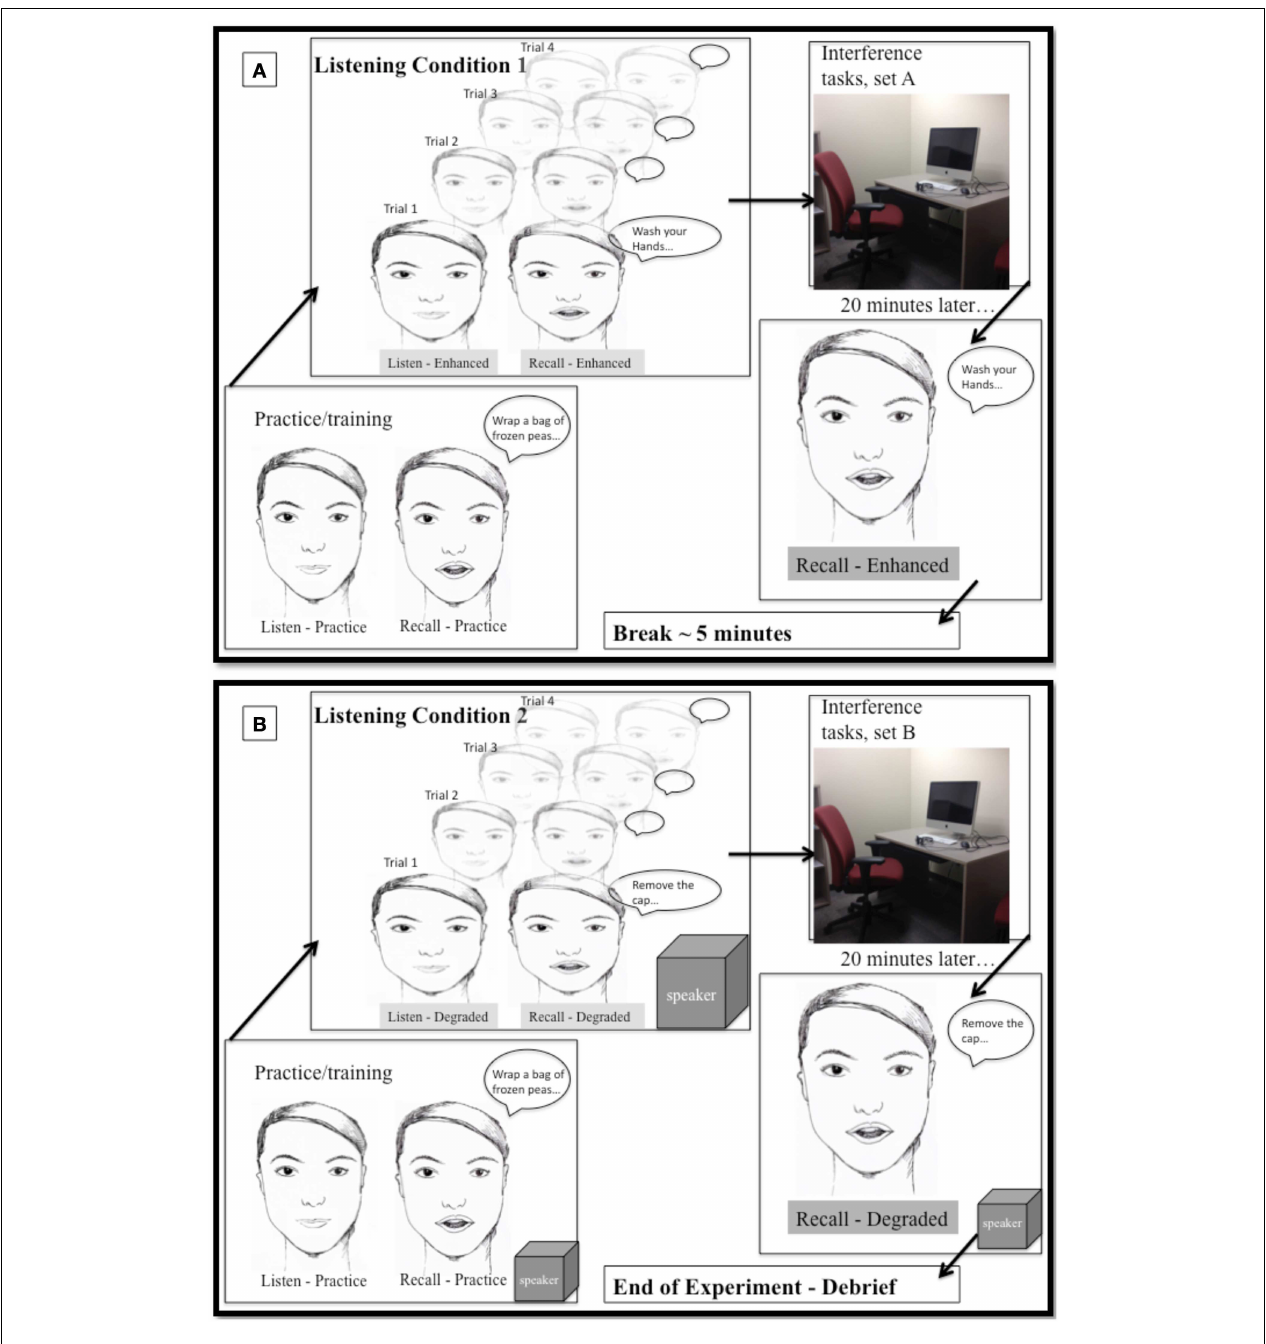
FIGURE 3 | Illustration of procedures for experiment (second session). (A) Top panel: Listening condition 1, enhanced (clear speech), via insertion earphones. Participant instructed and practice session. Trials of listening and recall × 4. Move to experiment room for 20min of interference/filler tasks (set A). Move back to sound booth for delayed